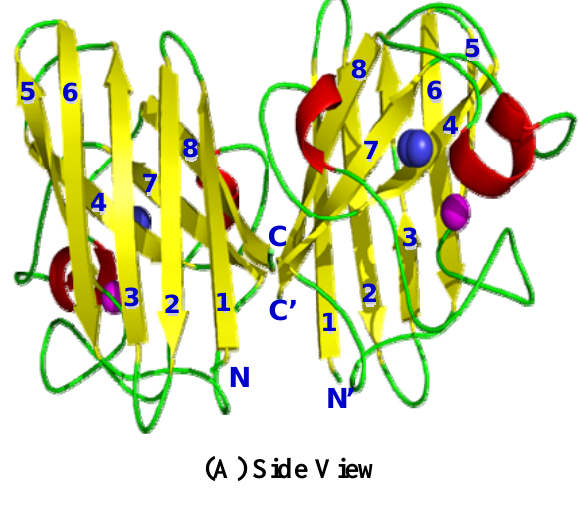
Figure 6. Predicted 3D structure model of cSOD1 and the dimer interface structure. The 3D structure model of cSOD1 was predicted using Swiss-model server [40]. ( A ) Each dimer contains 8 beta sheets. Active site metal ions are shown as spheres for copper (blue) and zinc (purple); ( B ) Top view of cSOD1 reveals the β -barrel structure with 19.0 × 12.0 Å pore; ( C ) Dimer contact forming residues in chain A and B of cSOD1 are shown in magenta and marine colors,